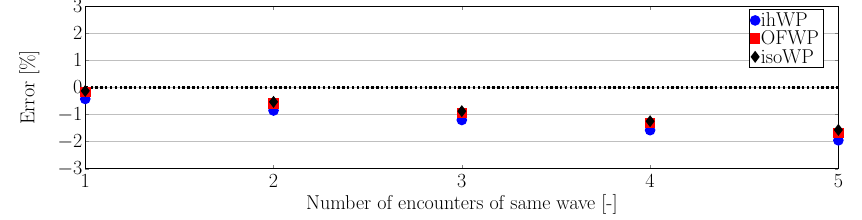
Figure 13. Relative deviation of measured wave height to target wave height over consecutive wave periods for the three different wave